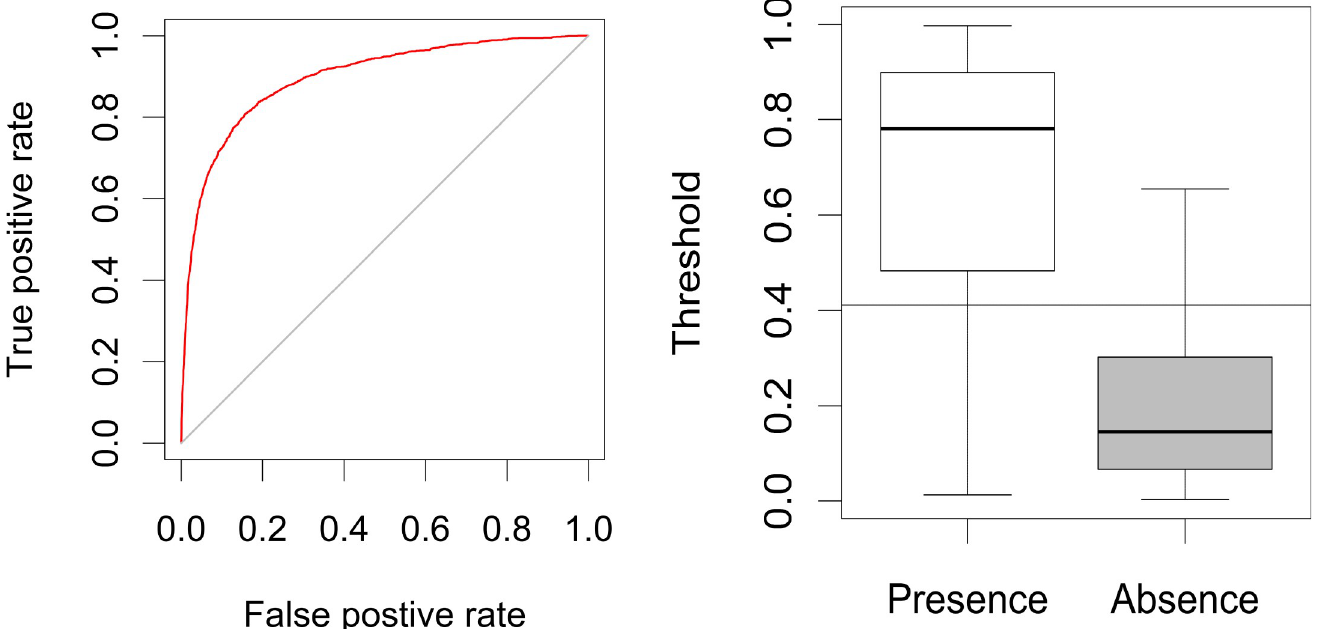
Fig 3. Left: Receiver operating characteristic (ROC) for MaxEnt. The ROC presents the trade-offs between the FPR and TPR at different thresholds. The area under the ROC curve (AUC) is a measure of the model’s ability to successfully discriminate between presence and absence points for a range of probability thresholds. The diagonal line represents an AUC value of 0.5, equivalent to randomly guessing whether an observation is a presence or an absence. An AUC of 1 would indicate that at some threshold, the model can discriminate between the two classes perfectly. Right: The predicted probabilities by the ensemble MaxEnt model for presence and absence points. The horizontal line lies at the optimal threshold (0.411). The figure demonstrates how many presence and absence points are correctly predicted as presence points if we were to convert the probabilities to binary certainties using the optimal threshold.